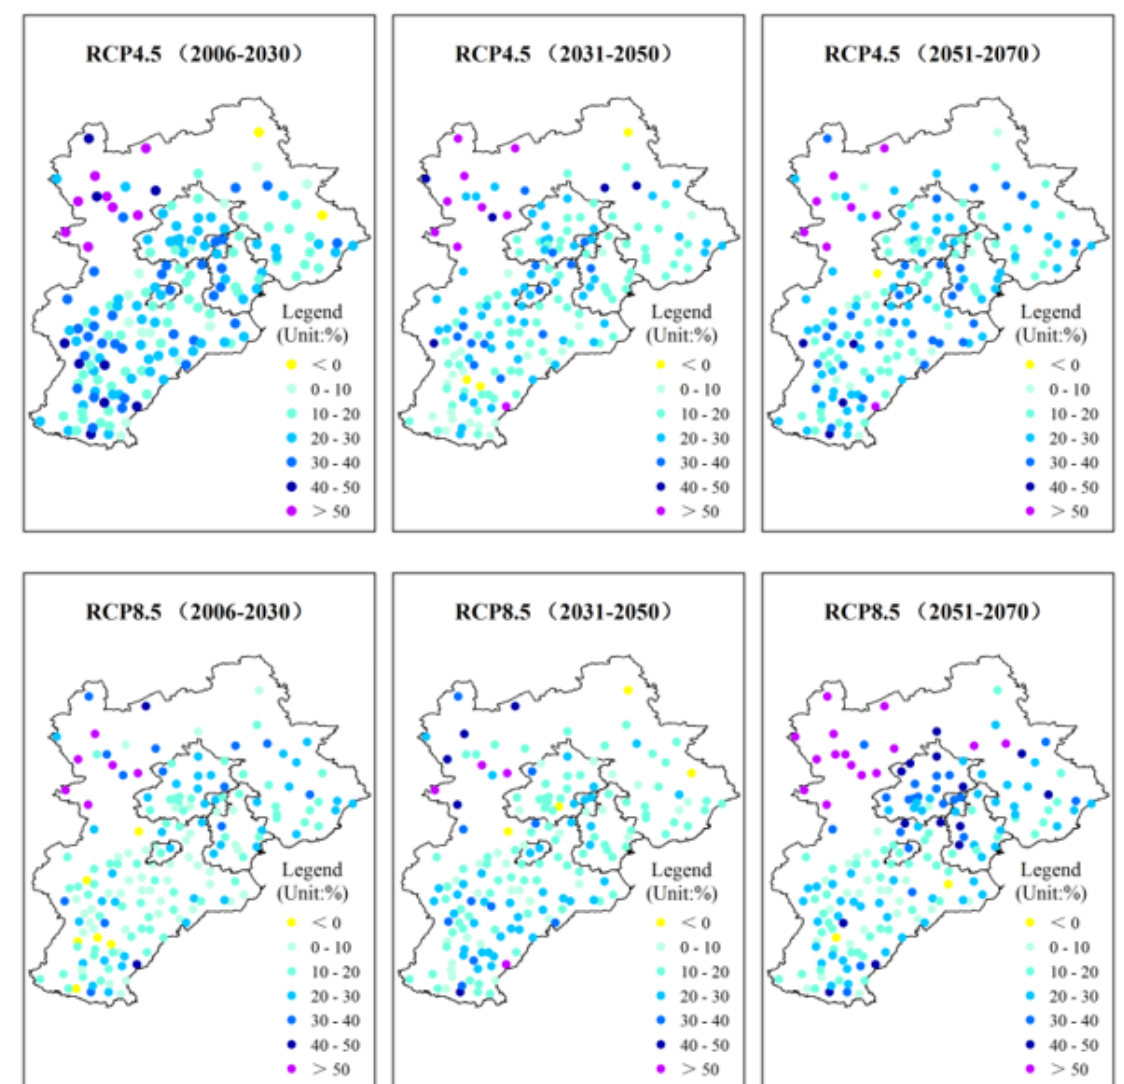
Figure 5. Spatial distribution of annual percentage changes of Exc40 across the Beijing-Tianjin-Hebei region during 2006–2030, 2031–2050, and 2051–2070, compared with 1961–2005. For Px1d under RCP 4.5, the percentage changes averaged across the Beijing-Tianjin- Hebei region and the five GCMs during 2006–2030, 2031–2050, and 2051–2070 were 12.8%, 8.3%, and 12.6%, respectively. Only the model NorESM1-M in 2031–2050 showed a decreas- ing trend, which is in contrast to most other GCMs. Under RCP 8.5, the averaged greatest one-day precipitation across the Beijing-Tianjin-Hebei region also showed an increasing trend in the future. However, the changes relative to 1961–2005 during 2006–2030 and 2051–2070 were 10.8% and 8.6%, respectively (less than the increases under RCP 4.5). The change for 2031–2050 was 11.4%, which is more than that under RCP 4.5. Figure 6 shows the spatial distribution of percentage changes of Px1d across the Beijing-Tianjin-Hebei region during the three time periods compared with 1961–2005. The variation in Px1d between stations was larger than that of the former indices, which demonstrates the need for downscaling. The increase at some stations would be more than 40%, while at other stations in the southern and central Beijing-Tianjin-Hebei region, this index is expected to decrease by more than 20%. Specifically, 25.3%, 33.9%, and 29.3% of stations are projected to experience negative changes under RCP 4.5 during 2006–2030, 2031–2050, and 2051–2070, respectively. Furthermore, under RCP 8.5 in the future three periods, nearly one third